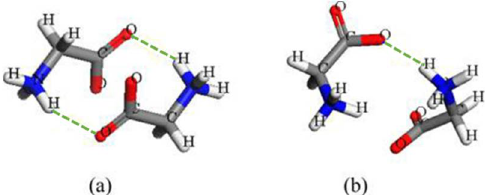
Figure 7. Hydrogen-bonded cyclic dimer ( a ) and open-chain dimer ( b ) respectively presented in α form and γ form of glycine [113]. Reprinted/adapted with permission from [113]. Copyright 2012, copyright Yani, Y.; Chow, P.S.; Tan, R.B.H.